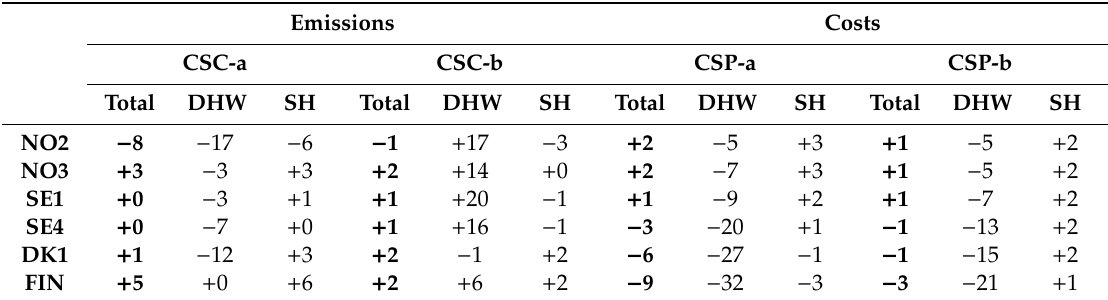
Table 6. Cost and CO 2eq. emission savings separated for DHW and SH (results are given in %).